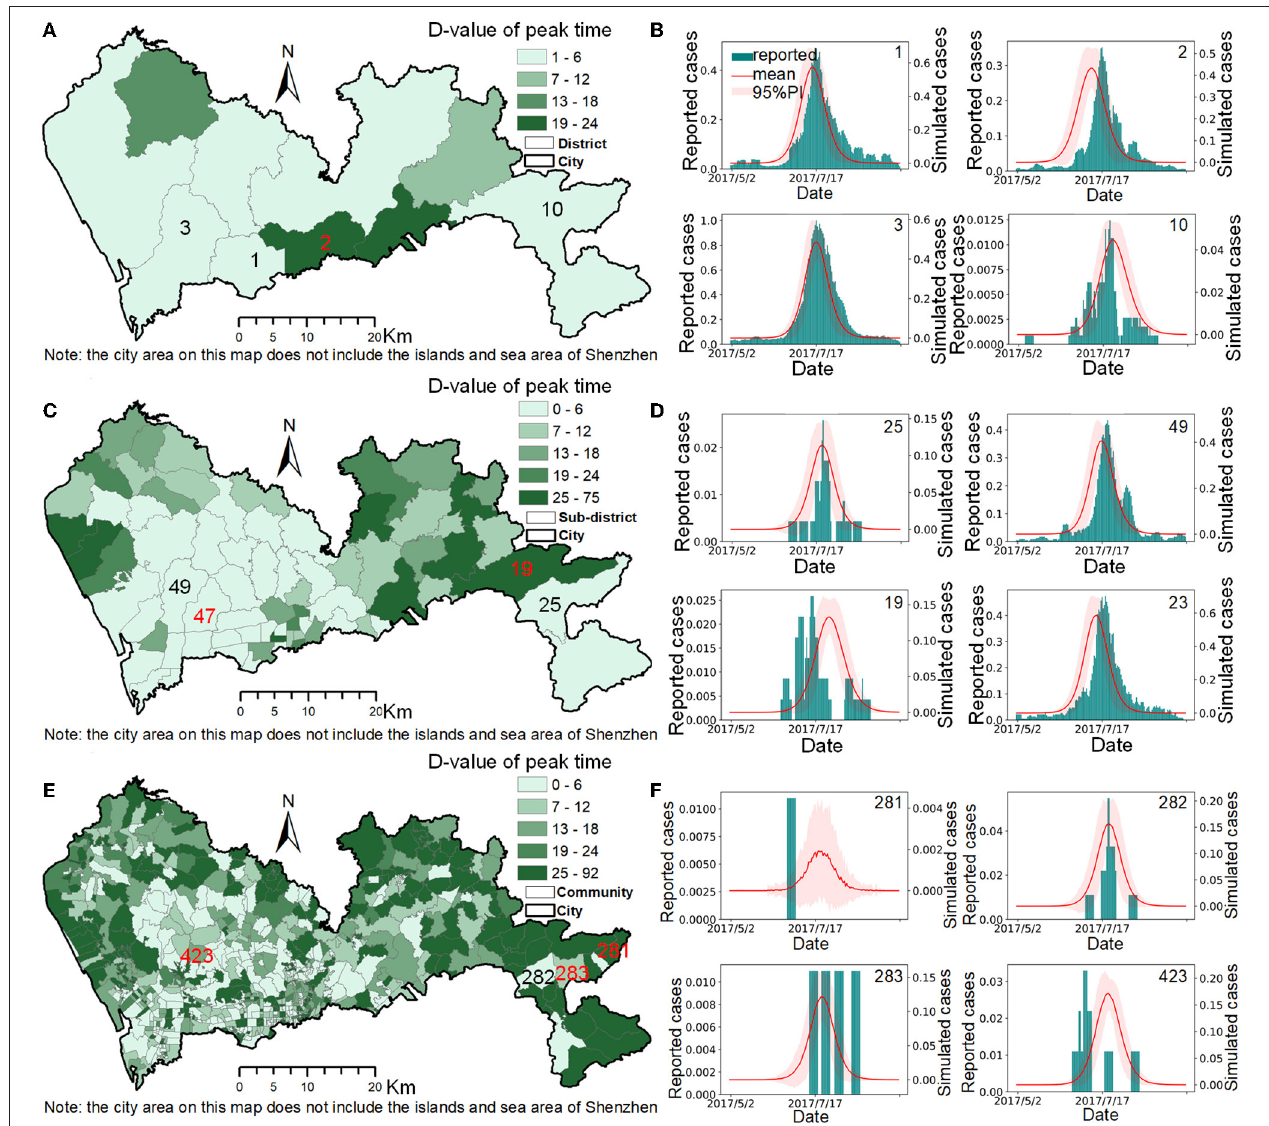
FIGURE 4 | The model accuracy at different spatial scales. (A,C,E) are the spatial distributions of the 1 peak values at the district, sub-district, and community scales. (B,D,F) are the comparisons between the simulation cases and reported cases of selected typical spatial units at the district, sub-district, and community